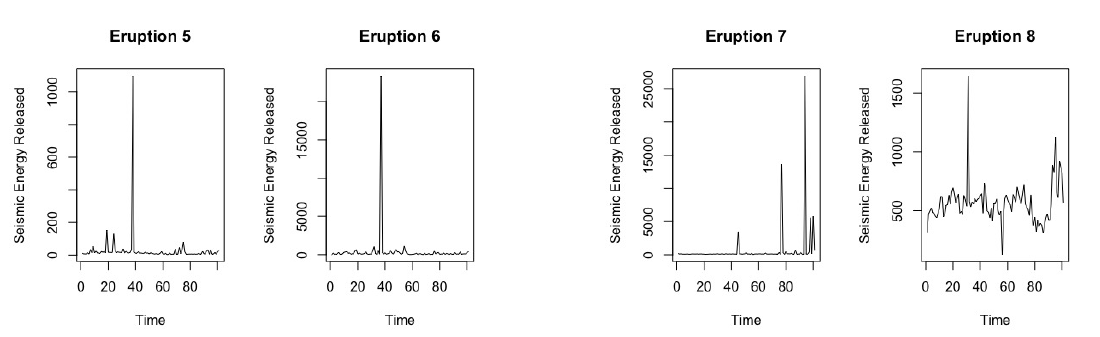
Figure 8. Plots of volcanic eruption numbers 5, 6, 7 and